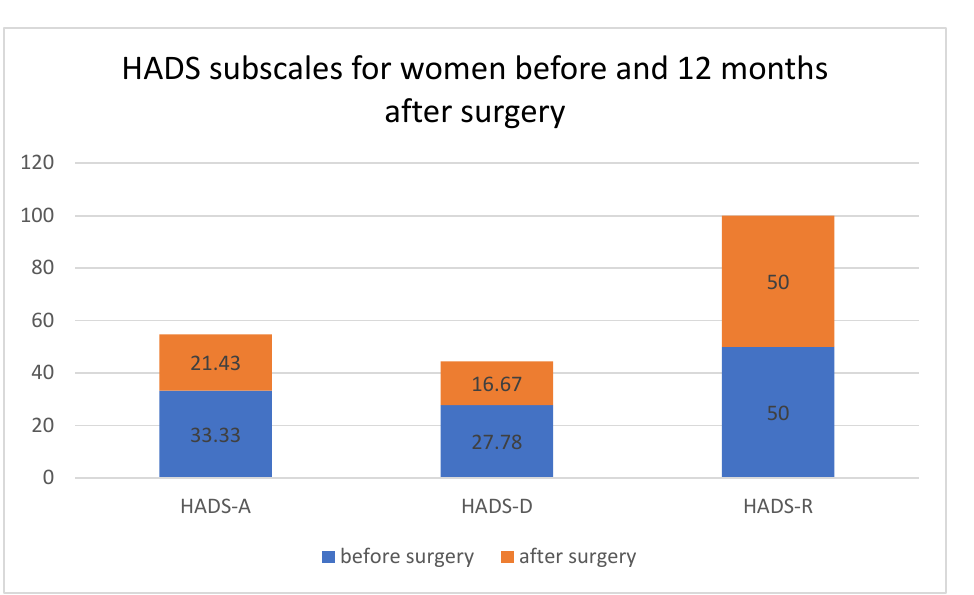
Figure 1. HADS subscales for women before and 12 months after surgery. Medians differed between HADS-A, HADS-D and HADS-R (A — anxiety, D — depression, R — aggression, Hospital Anxiety and Depression Scale) before and 12 months after surgery. Table 2. HADS subscales for women before and 12 months after surgery.